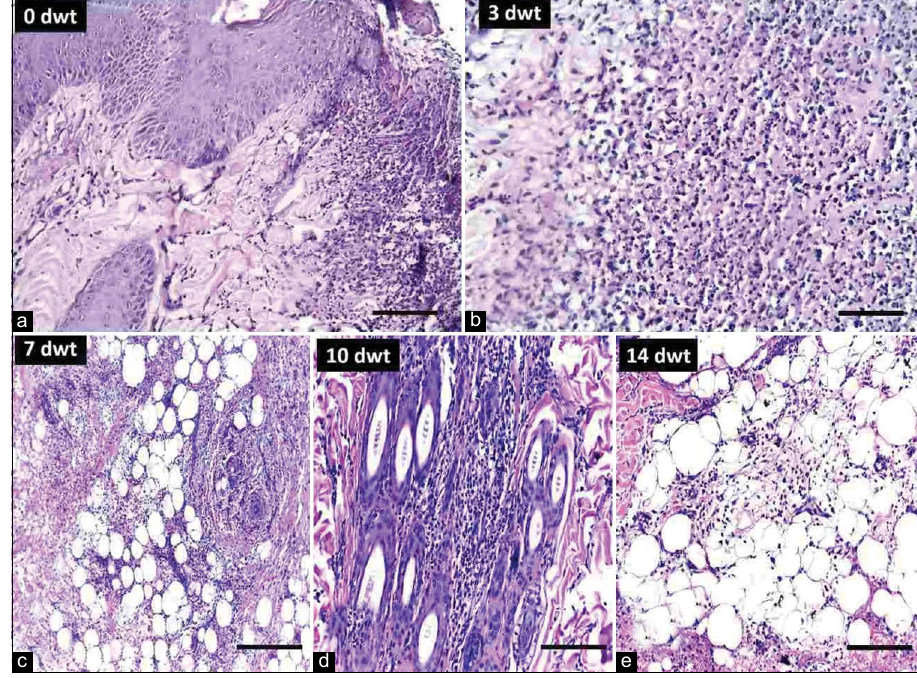
Figure-4: Untreated group. (a) On zero day of the experiment, the skin showing epidermal necrosis dermal collagen necrosis and severe neutrophils infiltration in the epidermis, dermis, and around the hair follicles; H and E 20×. (b) On 3 rd day without treatment (DWT), the skin showed severe necrosis and neutrophil infiltration; H and E 40×. (c) On7 th DWT, the skin has severe inflammation in the subcutaneous fat and arteritis; H and E 10×. (d) On 10 th DWT, the skin showing inflammatory cells invades the hair follicles; H and E 20×. (e) On 14 th DWT, the skin showing moderate inflammatory cells in the subcutaneous tissue; H and E